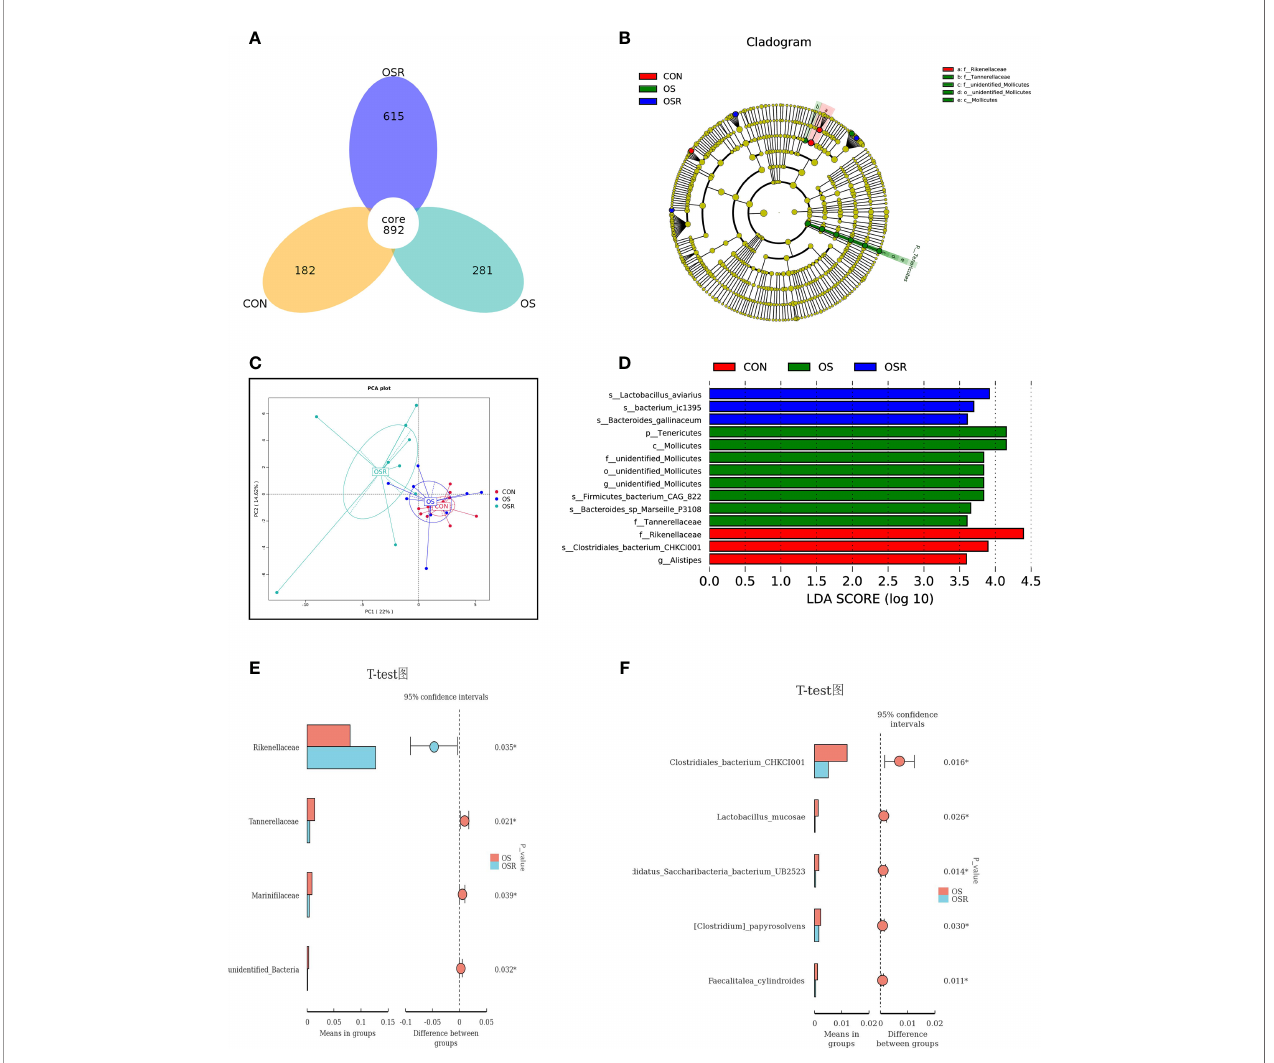
FIGURE 6 | Dietary resveratrol supplementation modulated the oxidative stress (by tBHP) and induced a decrease in microbiota diversity (Exp.1). (A) Schematic illustration of the experimental design. (A) Vann diagram. (C) The principal coordinate analysis (PCoA) of the cecum microbiota based on unweighted UniFrac metric. (B, D) Linear discrimination analysis coupled with effect size (LEfse) identi fi ed the most differentially abundant taxa in the cecum with LDA signi fi cant threshold > 3 were shown. (Red) CON enrichment taxa; (Green) OS enrichment taxa; (Blue) OSR enrichment taxa. (E,F) Analysis of different species between groups at class (E) and species (F) levels. CON, same dosage of PBS; OS, 800 m mol/kg BW of tBHP. Statistical signi fi cance was evaluated by the Student ’ s T-test, * p <